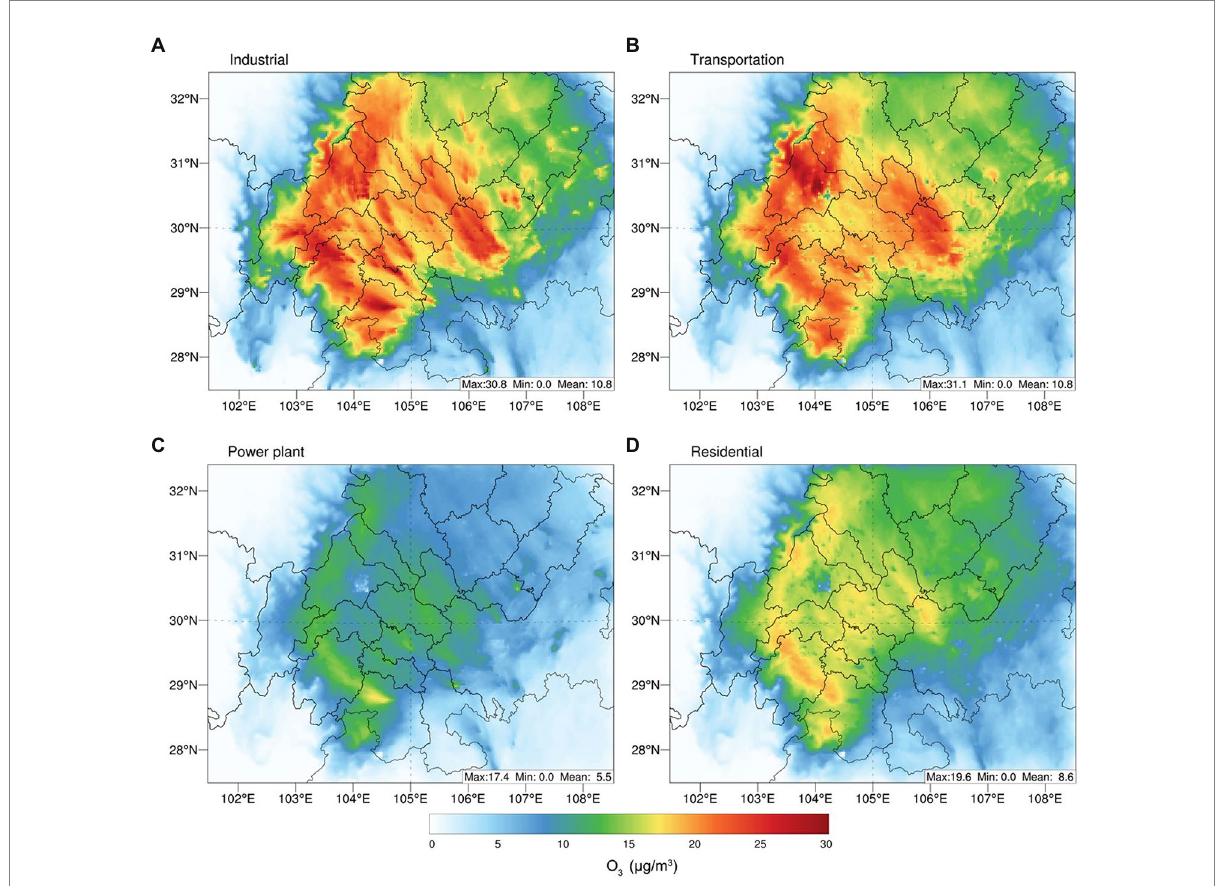
FIGURE 6 Sector-based anthropogenic contributions to MDA8 O 3 concentrations across the SCB from 1 June to 6 June, 2019. (a) Industrial, (b) transportation, (c) power plant, (d)